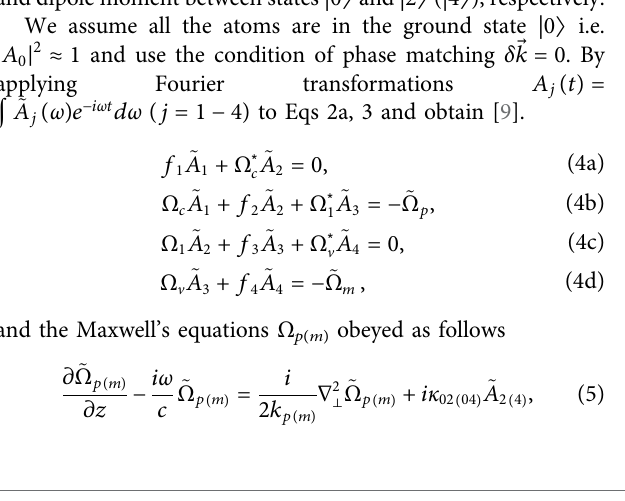
Frontiers in Physics |